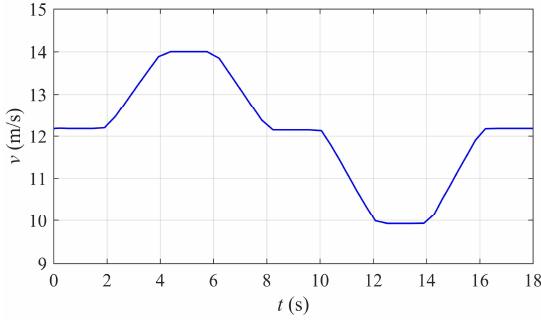
Figure 4. Wind speed profile.